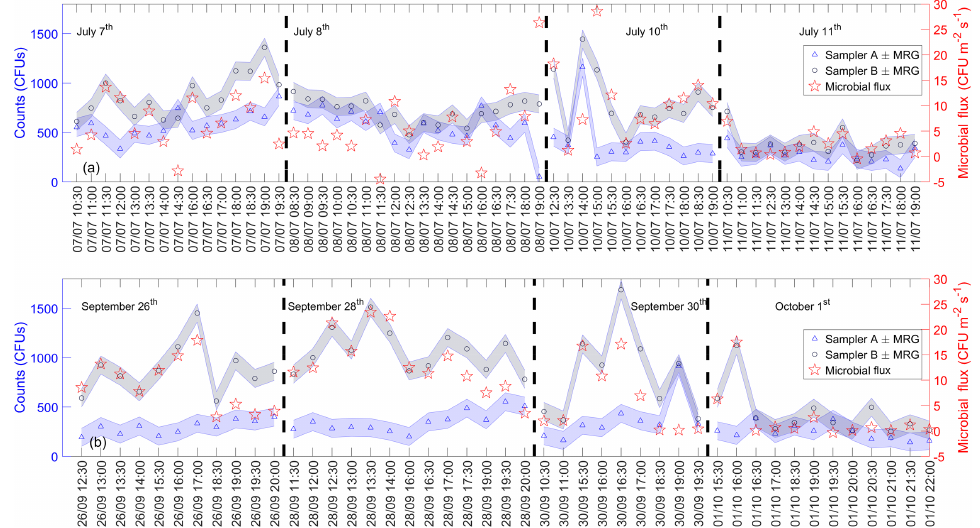
Figure 4. Details of the relationship between counted CFUs from the Burkard samplers and the estimated fluxes for the campaigns of July (a) and September (b) 2015.